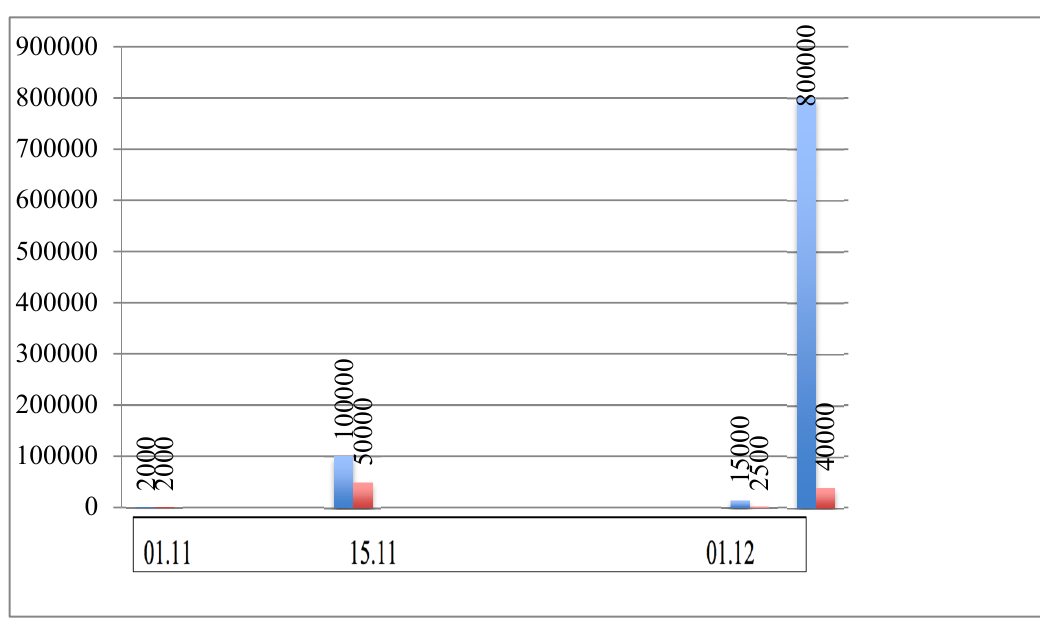
Figure 3. The number of protesters in Kiev from November to December 2013 (the opposition data segment is marked in blue, the Ministry of Internal Affairs data are marked in red). Source : ([26], pp.